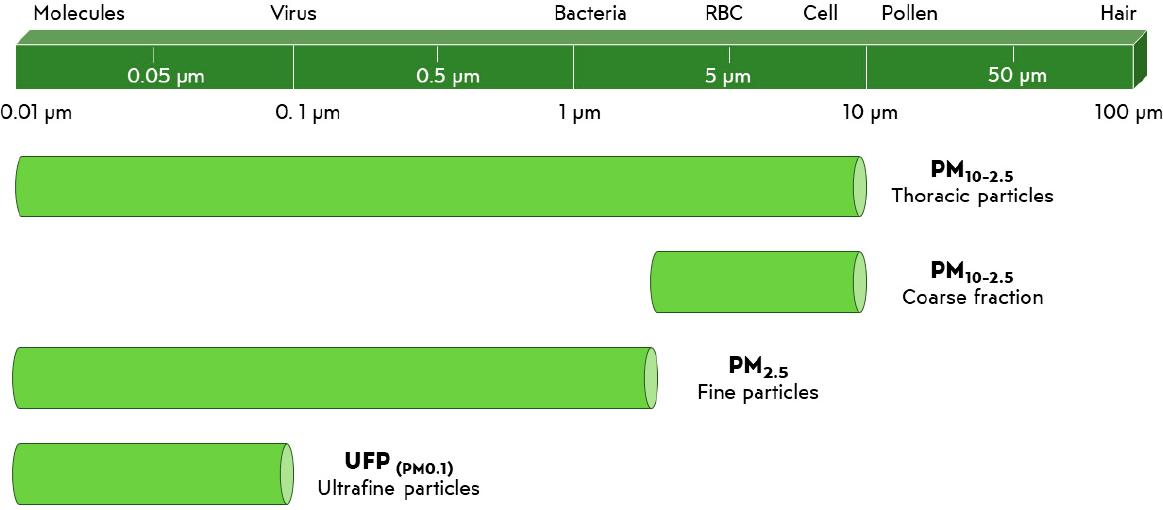
Figure 1. Cycle of pollution from the emission to the impact on people and environment.